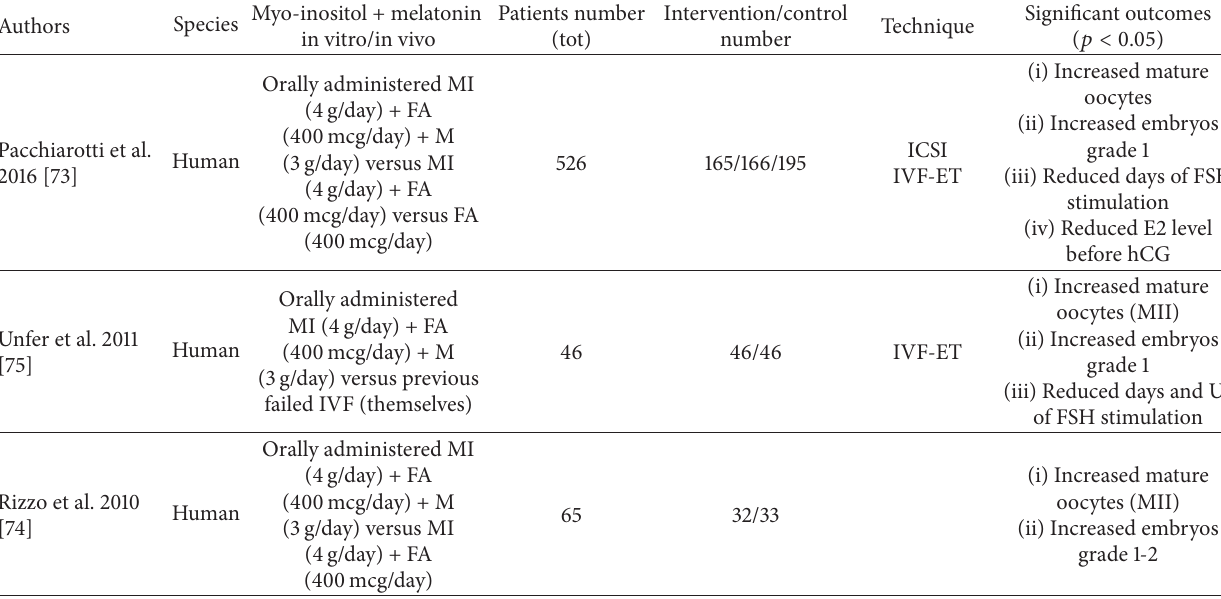
Table 3: Effects of myo-inositol + melatonin supplementation during